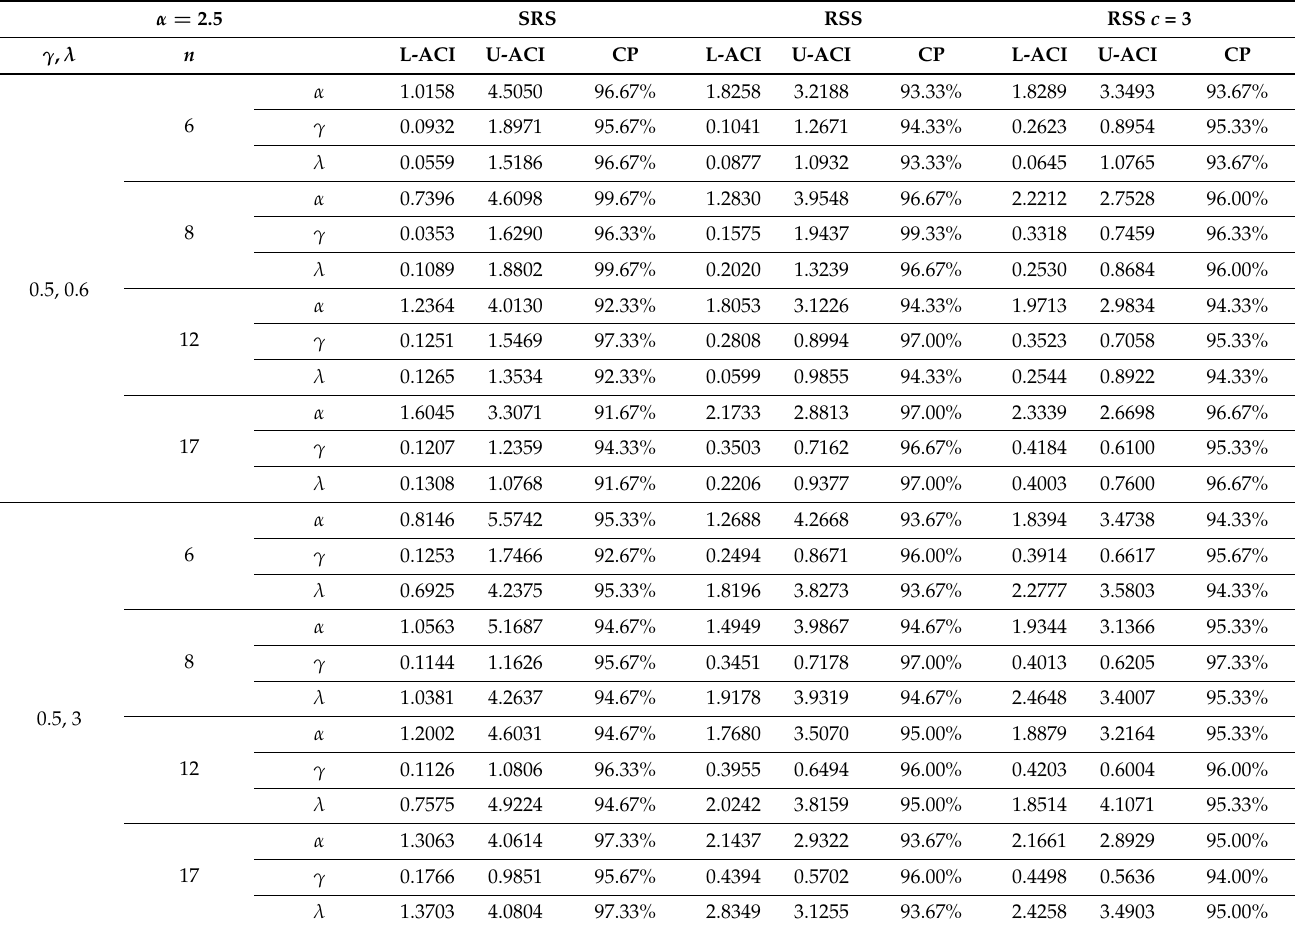
Table 8. Confidence intervals with CP for the parameters of the HL-INH distribution: α =